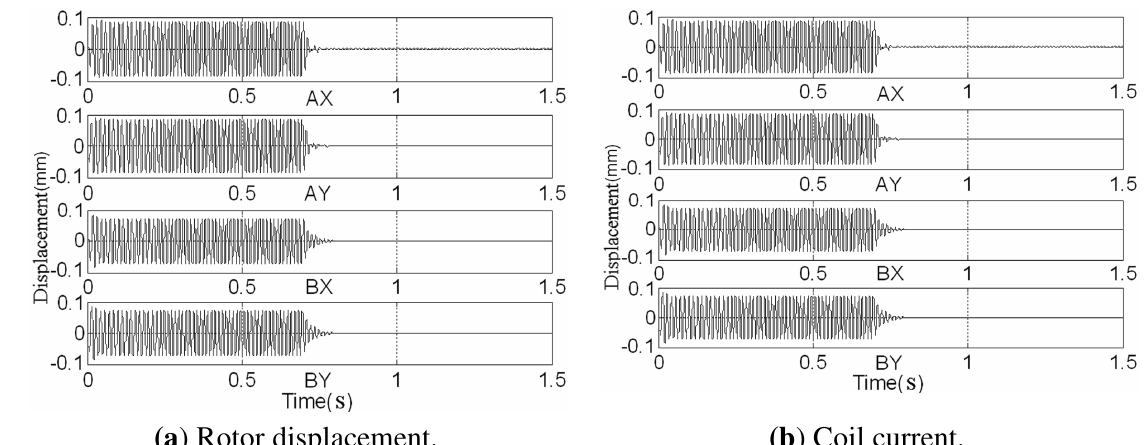
Figure 14. Signals before and after adding the GPF (simulation performed with Simulink).